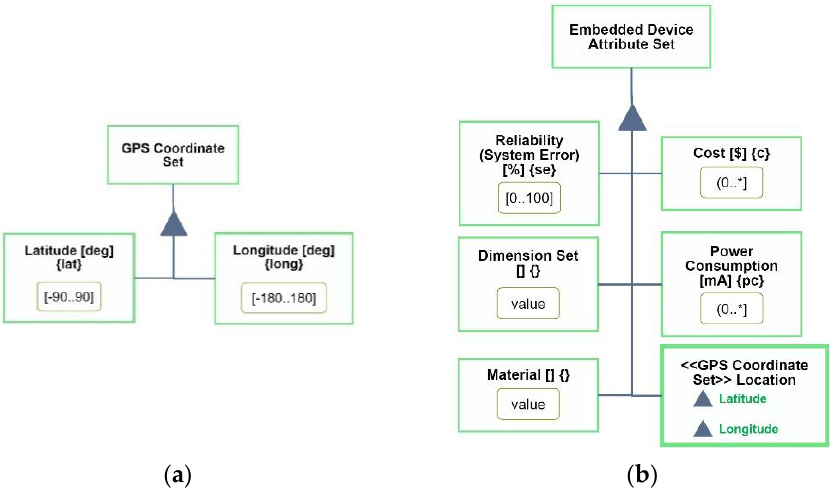
Figure 13. ( a ) The GPS Coordinate Set stereotype ( b ) The Embedded Device Attribute Set model, which serves as a